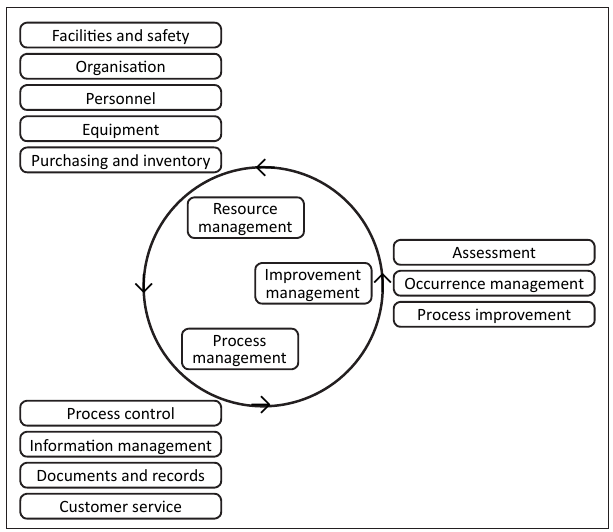
FIGURE 1: The framework with the 12 Quality System Essentials used to analyse to which extent the content of quality documents covers all aspects of total quality